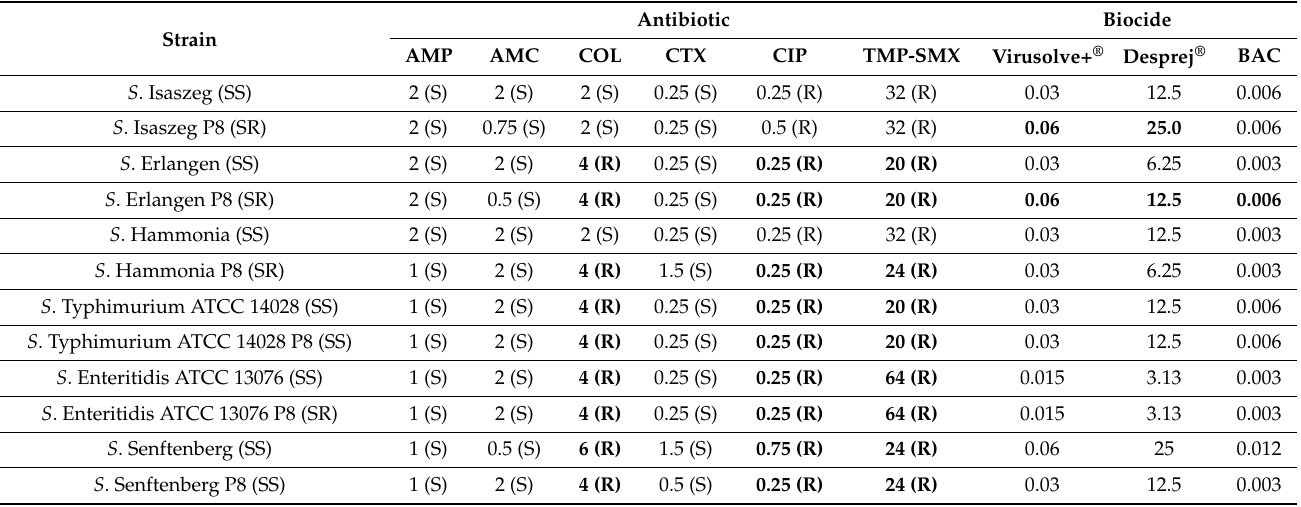
Table 2. Minimal inhibitory concentrations for six antibiotics (MIC, mg L − 1 ) and three disinfectants (MIC, %) in Salmonella enterica passages in 50% SPPP.